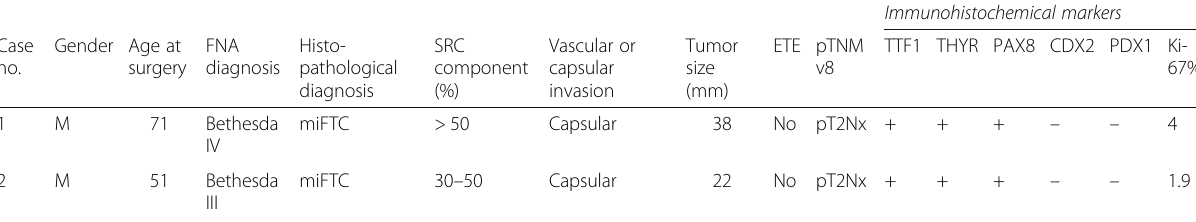
Table 1 Clinical and histopathological charateristics of the two patients with SRC-FTC Case no.